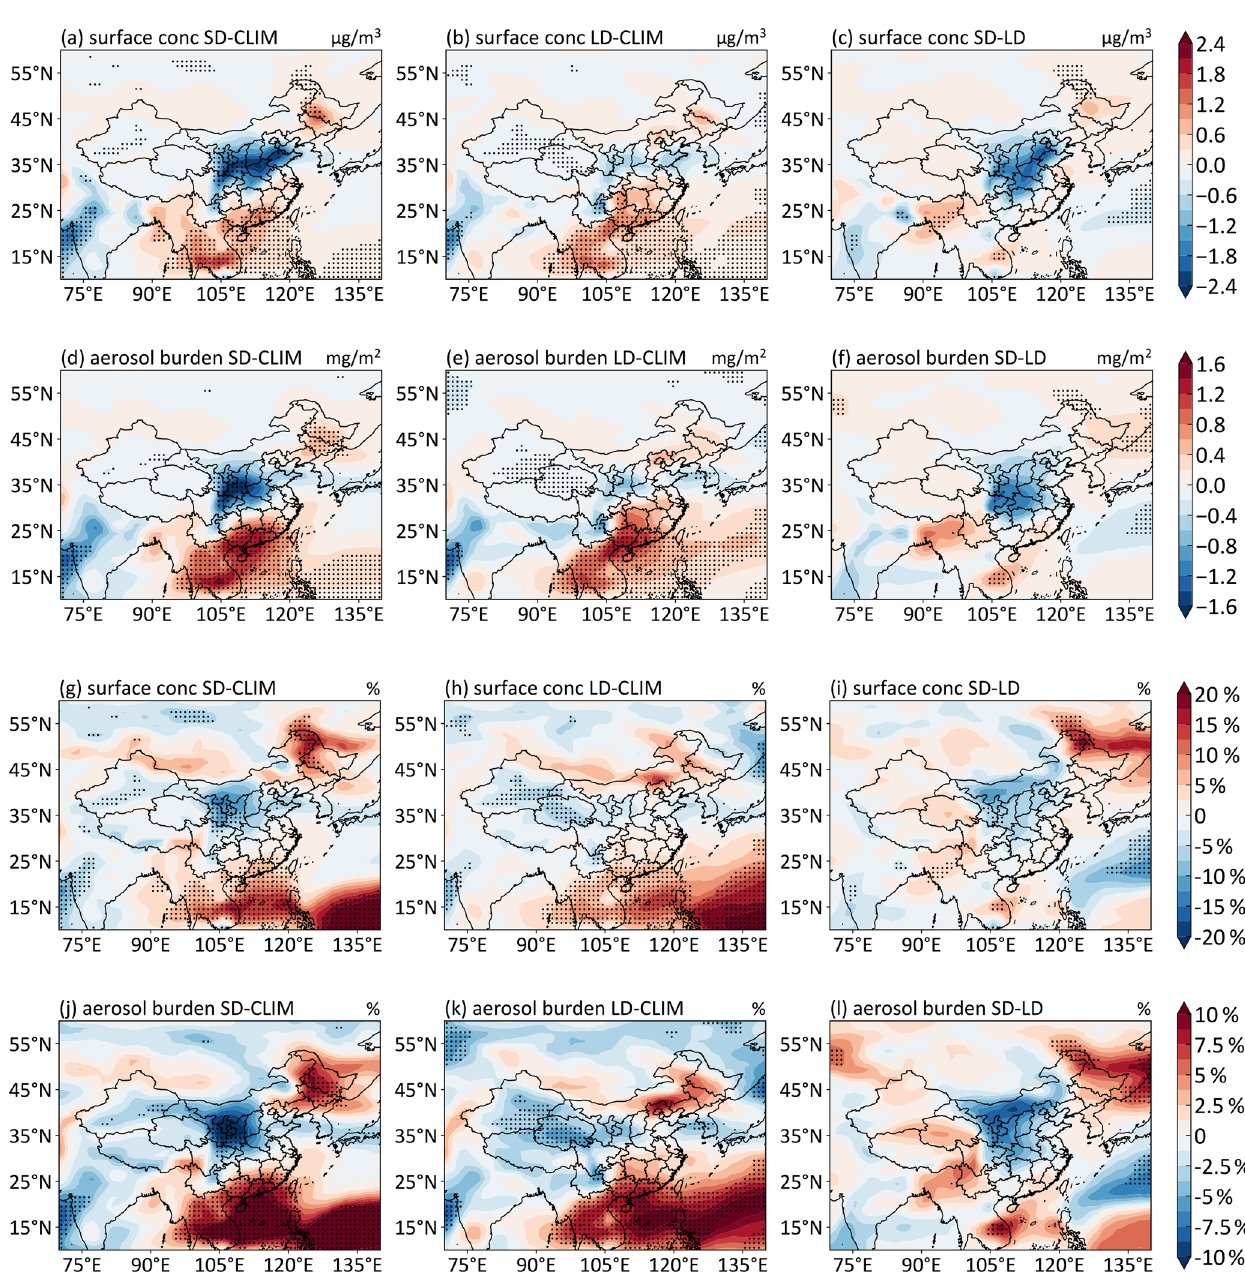
Figure 5. The absolute (a – f) and relative (h – l) composite differences in DJF mean near-surface PM 2 . 5 concentrations (µgm − 3 ) and aerosol column burdens (mgm − 2 ) between SD and CLIM (a, d, g, j) , LD and CLIM (b, e, h, k) , and SD and LD (c, f, i, l) . The stippled areas indicate statistical significance with 90% confidence from a two-tailed t